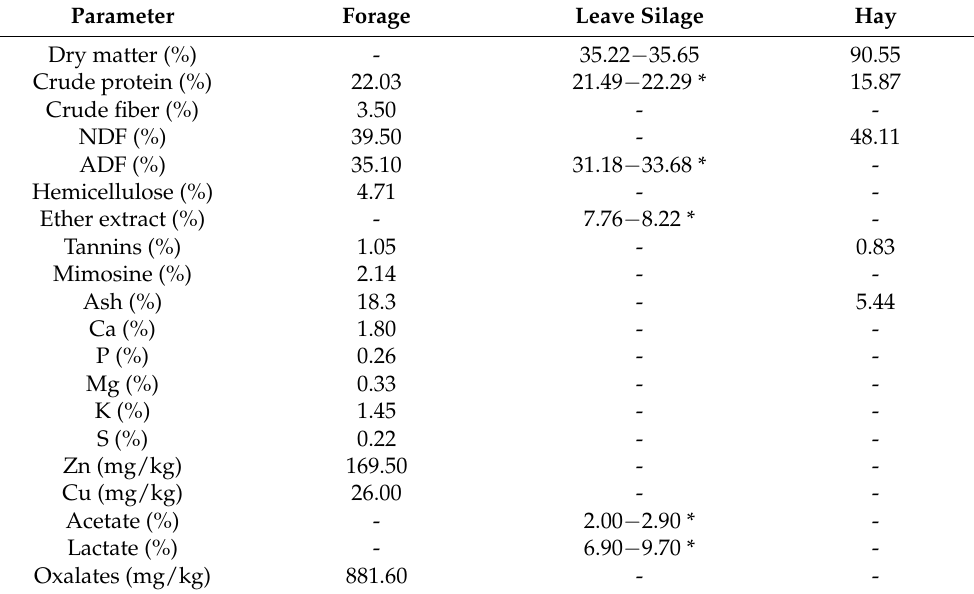
NDF = neutral detergent fiber; ADF = acid detergent fiber; * data reported on dry matter